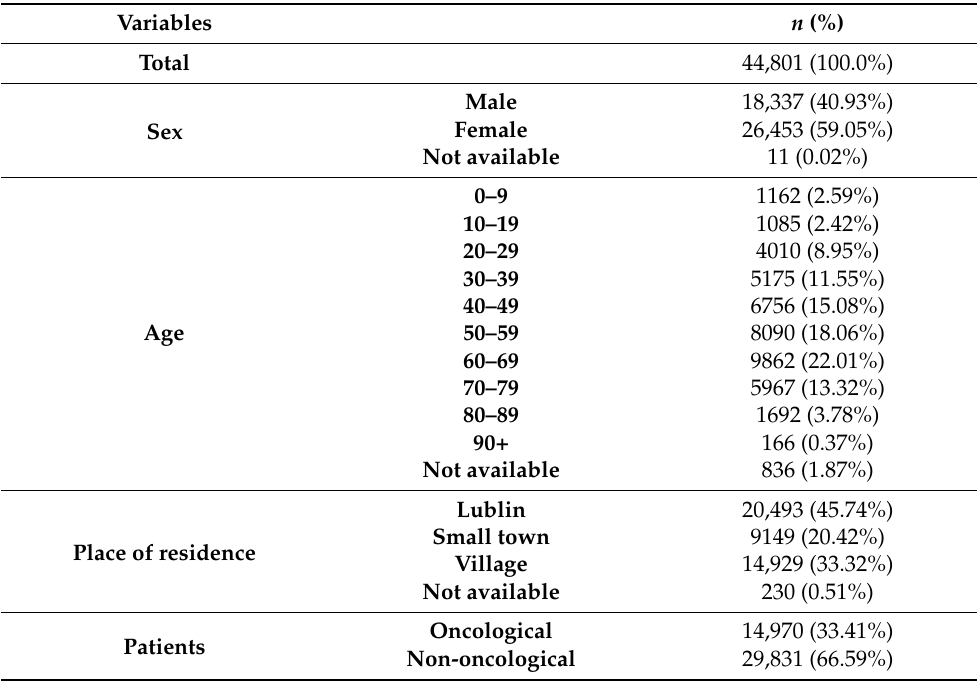
Table 1. Socio-demographical structure of tested